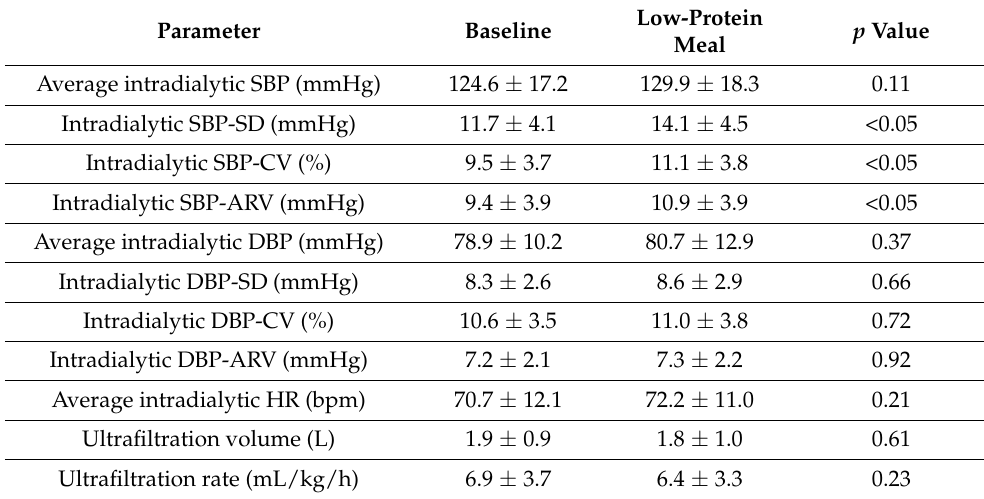
Table 3. Intradialytic BP variability parameters at baseline and in phase B of the